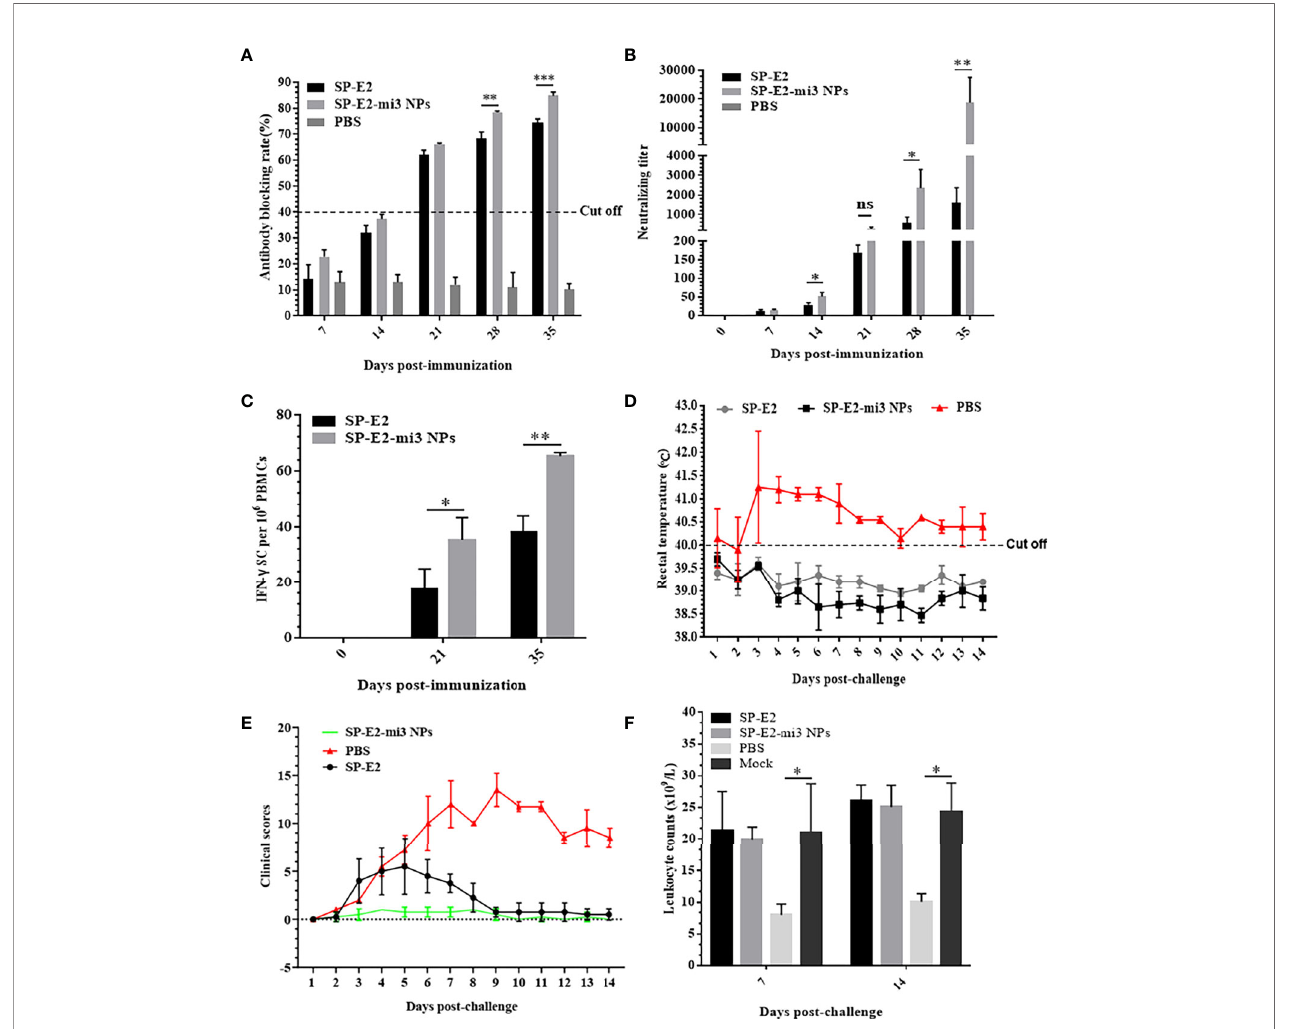
FIGURE 5 | Protective ef fi cacy of SP-E2-mi3 NPs in pigs. Three groups (n = 4) of 4-week-old pigs were intramuscularly inoculated with 10 m g SP-E2-mi3 NPs, 10 m g SP-E2 and PBS, respectively. The remaining group was left untreated. (A) Detection of CSFV-speci fi c antibodies in serum samples collected at the indicated time points using the IDEXX HerdChek ® CSFV Antibody Test Kit. (B) Detection of CSFV neutralizing antibody in pig serum samples. Neutralization titer was determined against CSFV Shimen strain. (C) Detection of CSFV-speci fi c IFN- g secreting cell responses against CSFV Shimen strain in vaccinated pigs. (D) Rectal temperatures of the pigs following CSFV Shimen strain challenge. (E) Clinical scores were evaluated based on fi ve CSFV-induced typical clinical symptoms, and the data was collected daily. (F) Leukopenia assessment in vaccinated pigs following CSFV Shimen strain challenge. Mock indicated the untreated healthy pigs. ns, not signi fi cant, p > 0.05; *p < 0.05; **p < 0.01; ***p <